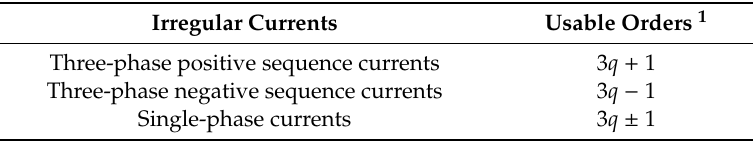
Table 1. Usable frequency orders for irregular